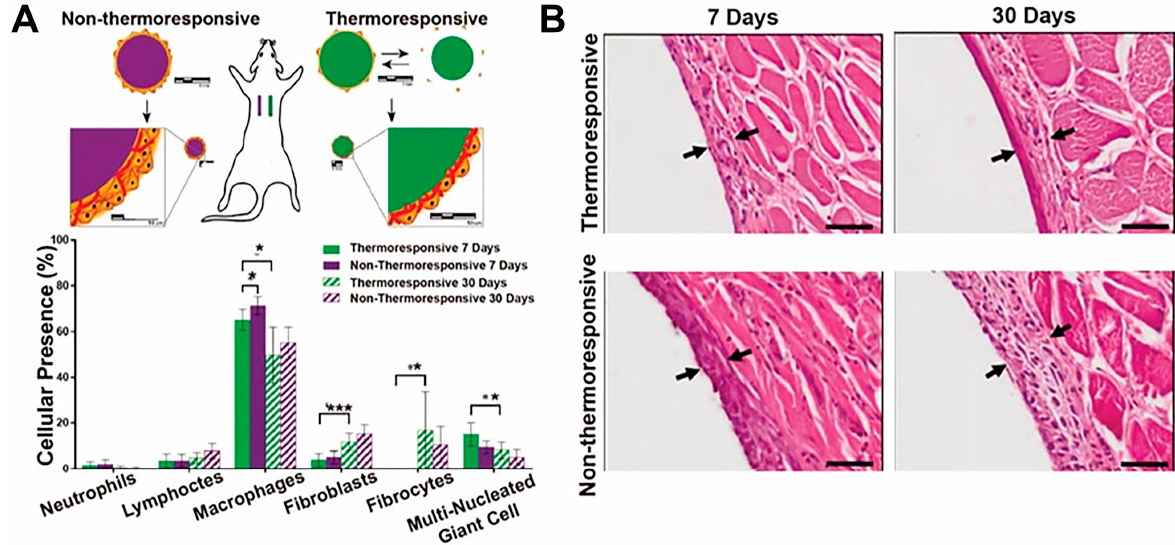
Figure 10. Schematic comparison between non-thermo-responsive and thermo-responsive hydrogels on immune cell response and fibrous capsule formation after 7 − and 30 − days post-implantation ( A ). *, ** and *** represent statistical significance ( p < 0.05 p < 0.01 and p < 0.001). Various surface patterns of PDMS and their impact on macrophage number and capsule thickness between 2 and 8-weeks post implantation (the black arrows demonstrate fibrous formation) ( B ). Reproduced with permission from ref. [83]. Copyright © 2020, The Korean BioChip Society and